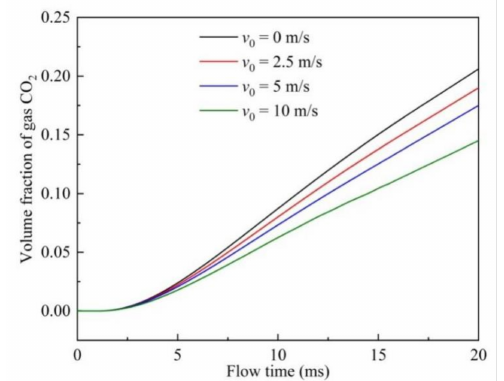
Figure 7. Effects of flow velocity on volume fraction of gas CO 2 .